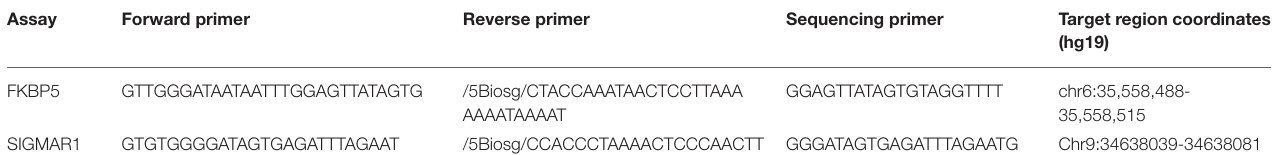
TABLE 2 | Bisulfite pyrosequencing assays.